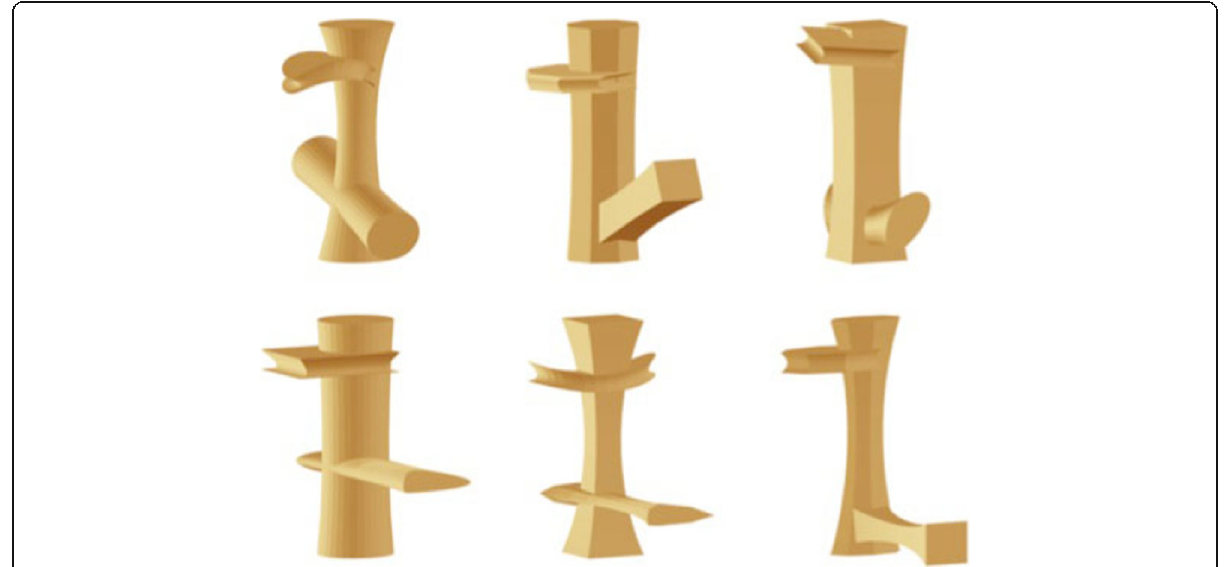
Fig. 2 Examples of six Ziggerin stimuli used on the Novel Object Memory